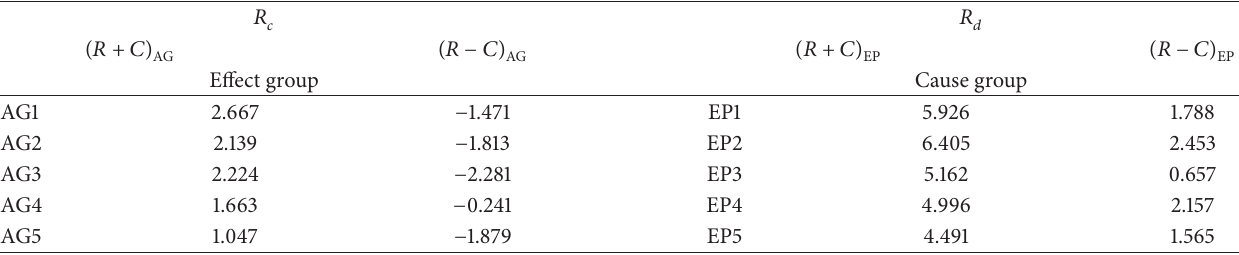
Table 2: Result of expanded DEMATEL for network